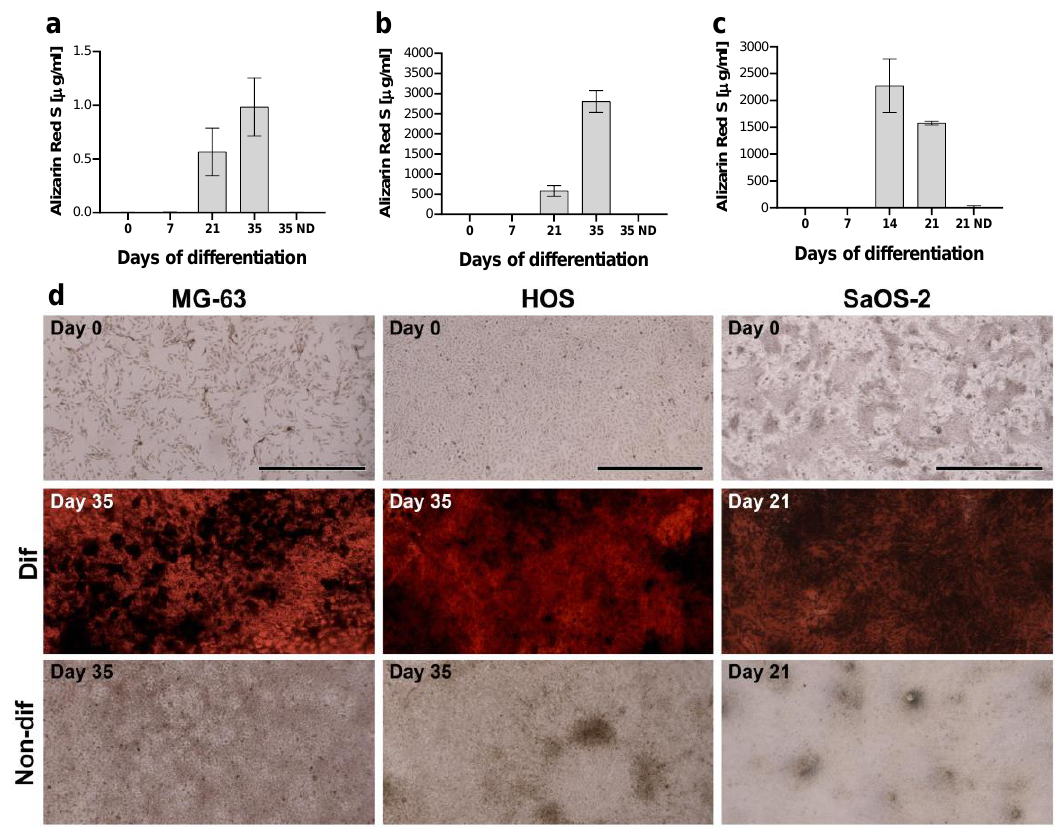
Figure 1. Exposure to differentiation media-induced mineralization in ( a ) MG-63, ( b ) HOS, and ( c ) SaOS-2 cells as determined by Alizarin Red S staining. Average deviation and standard deviation of spectrophotometric measurements of Alizarin Red S staining are shown for three independent experiments. ( d ) Representative microscopic images of cells at the beginning (day 0) and end (day 21 or 35) of differentiation procedure for differentiated and non-differentiated cells. Scale bars correspond to 1 mm.